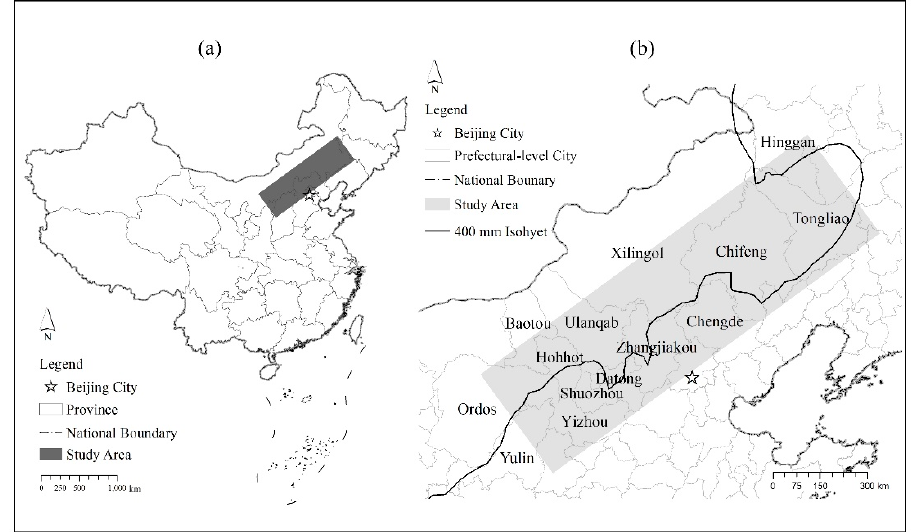
Figure 1. Location of the study area ( a ) within China and ( b ) at the local scale (Northern China) with annotation of the prefecture-level cities as well as the 400 mm mean annual precipitation isohyet considering the period 2006–2015.